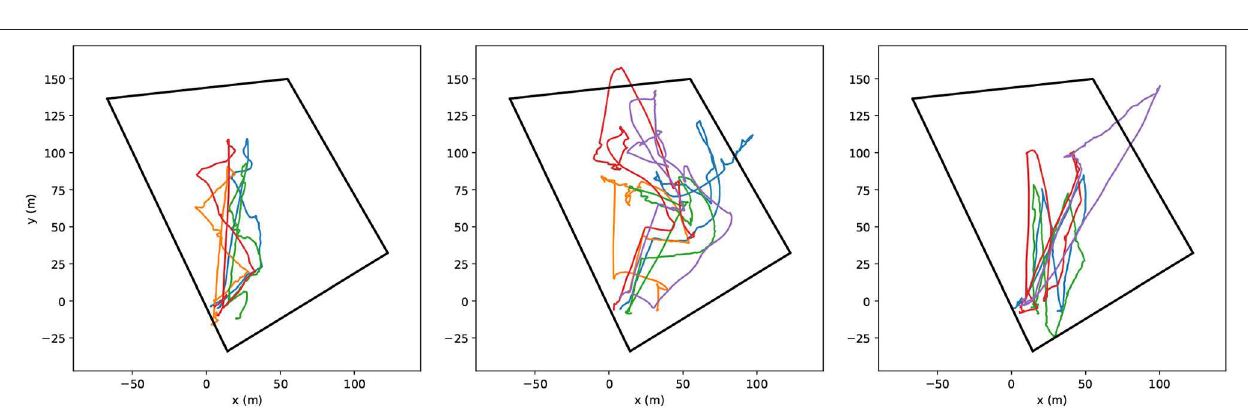
FIGURE 14 | Trajectories of five UAVs in semi-autonomous exploration task following the hotspots inputted by each operator. The black polygon represents the geofence.